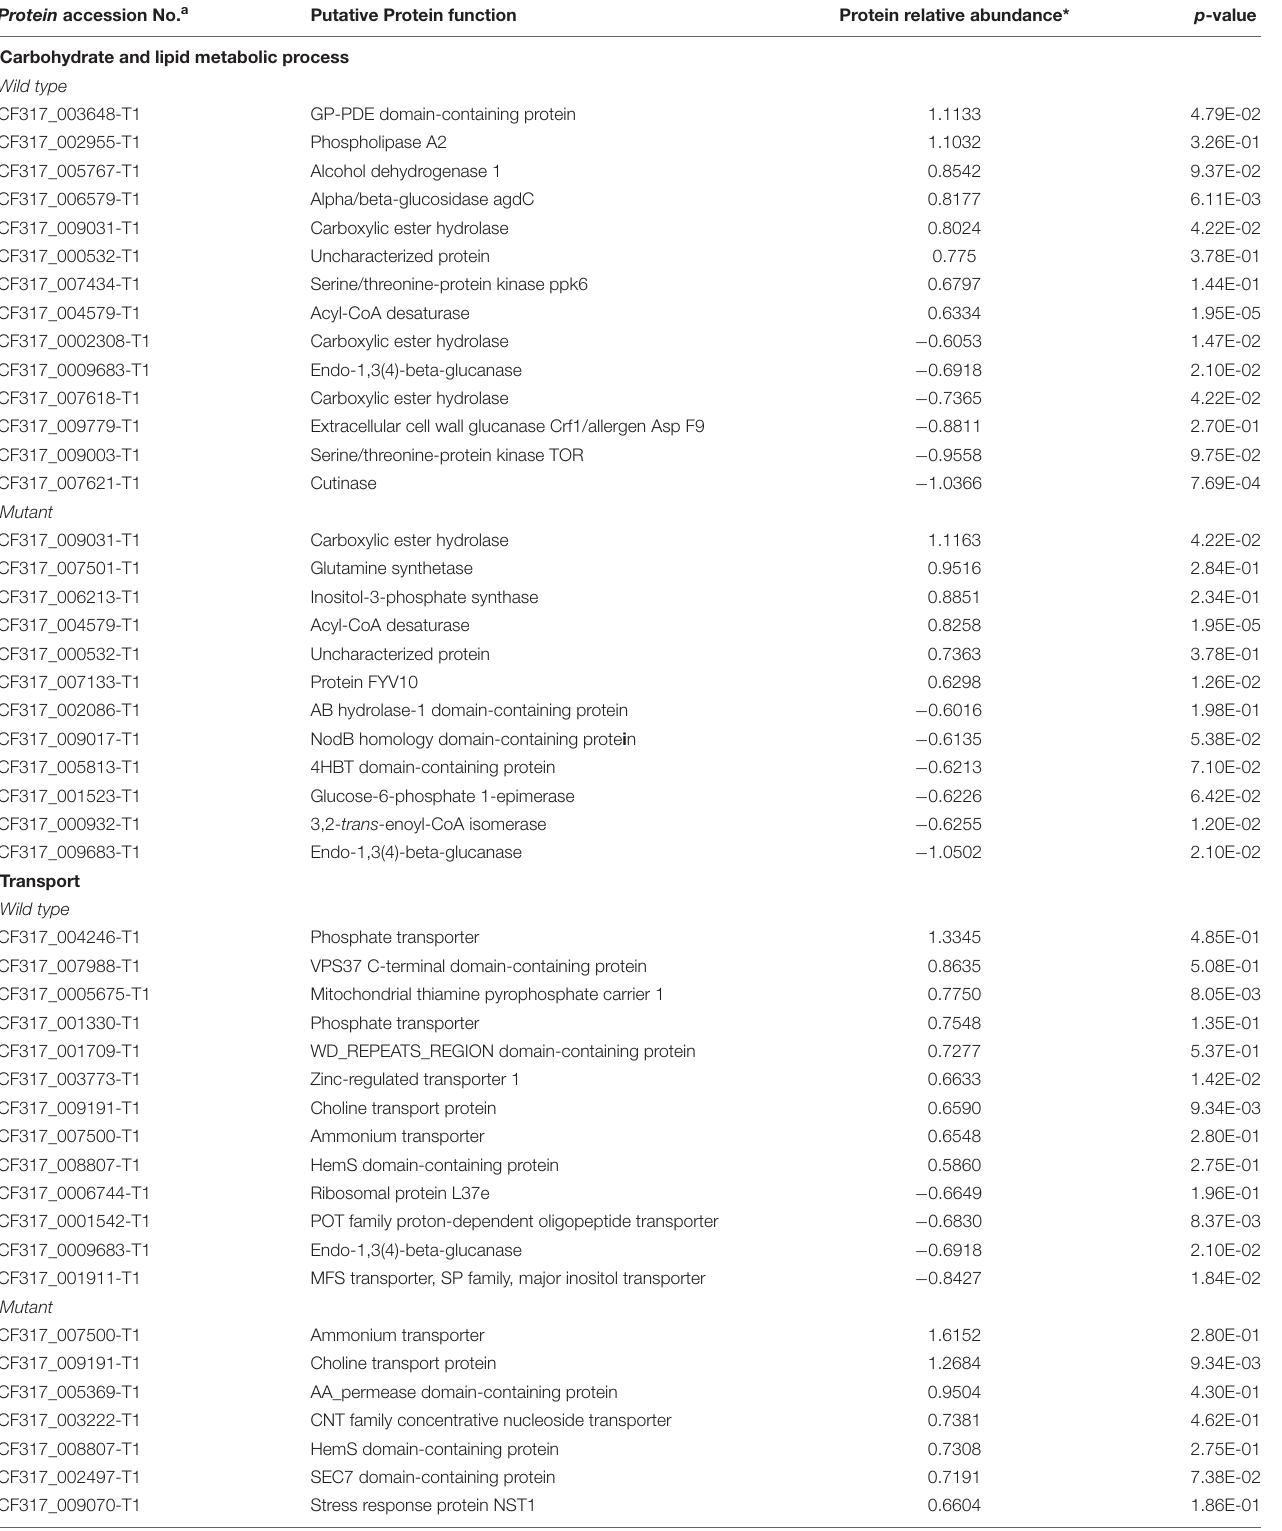
TABLE 1 | Most abundant biological process GO categories regulated under LSSMG in Knufia chersonesos Wt and Mut whole-cell proteome. Differentially expressed proteins included in each category are also shown. Protein accession No. a Putative Protein function Protein relative abundance* p